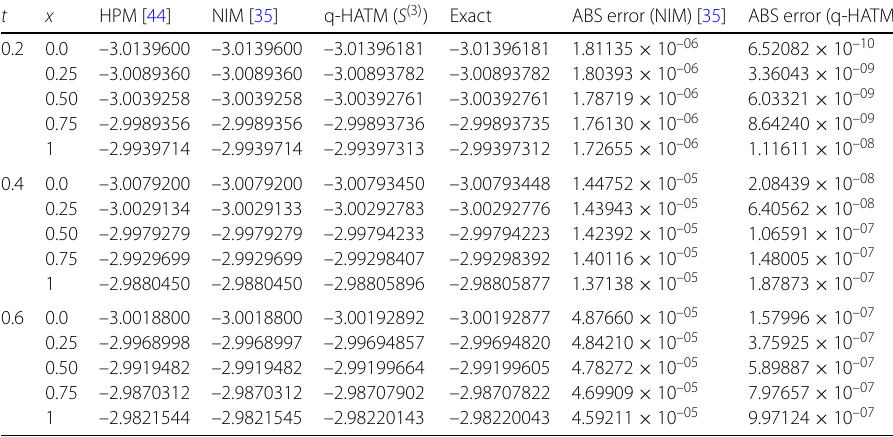
Table 4 The comparison of numerical result of S ( x , t ) obtained by NIM [35], HPM [44], q-HATM, and the exact solution Equation (32), also the absolute (ABS) errors when α = 1, (cid:2) = –1, k = η = 0.1, p = 1.5, r = –1.5, and n = 1 for Example 4.1